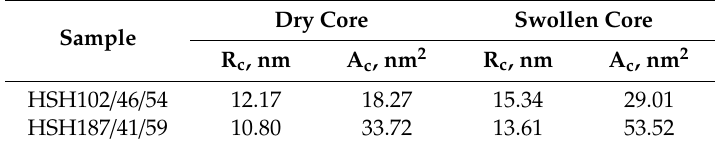
Table 5. Structural characteristics of the HSH triblock copolymer micelles in